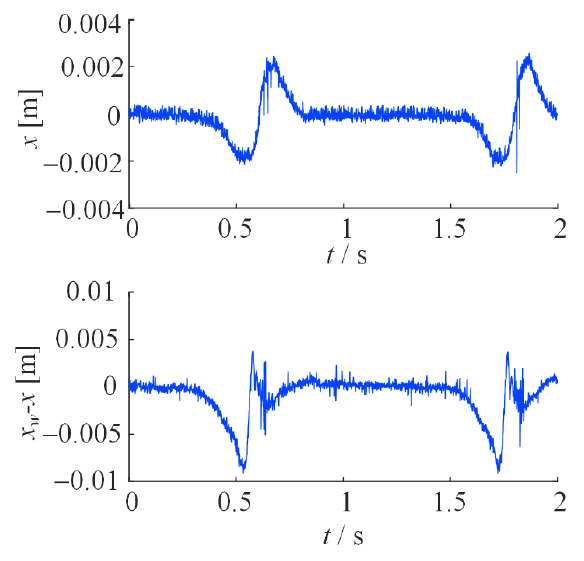
Figure 8. Test results of PID control.